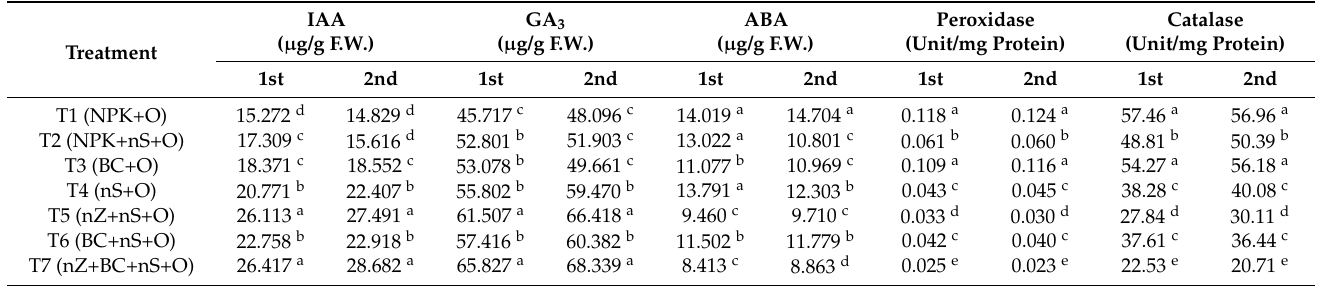
Table 8. Effect of nanoparticles on leaf hormones and enzymes activity of thyme plant during 2020 and 2021 growing